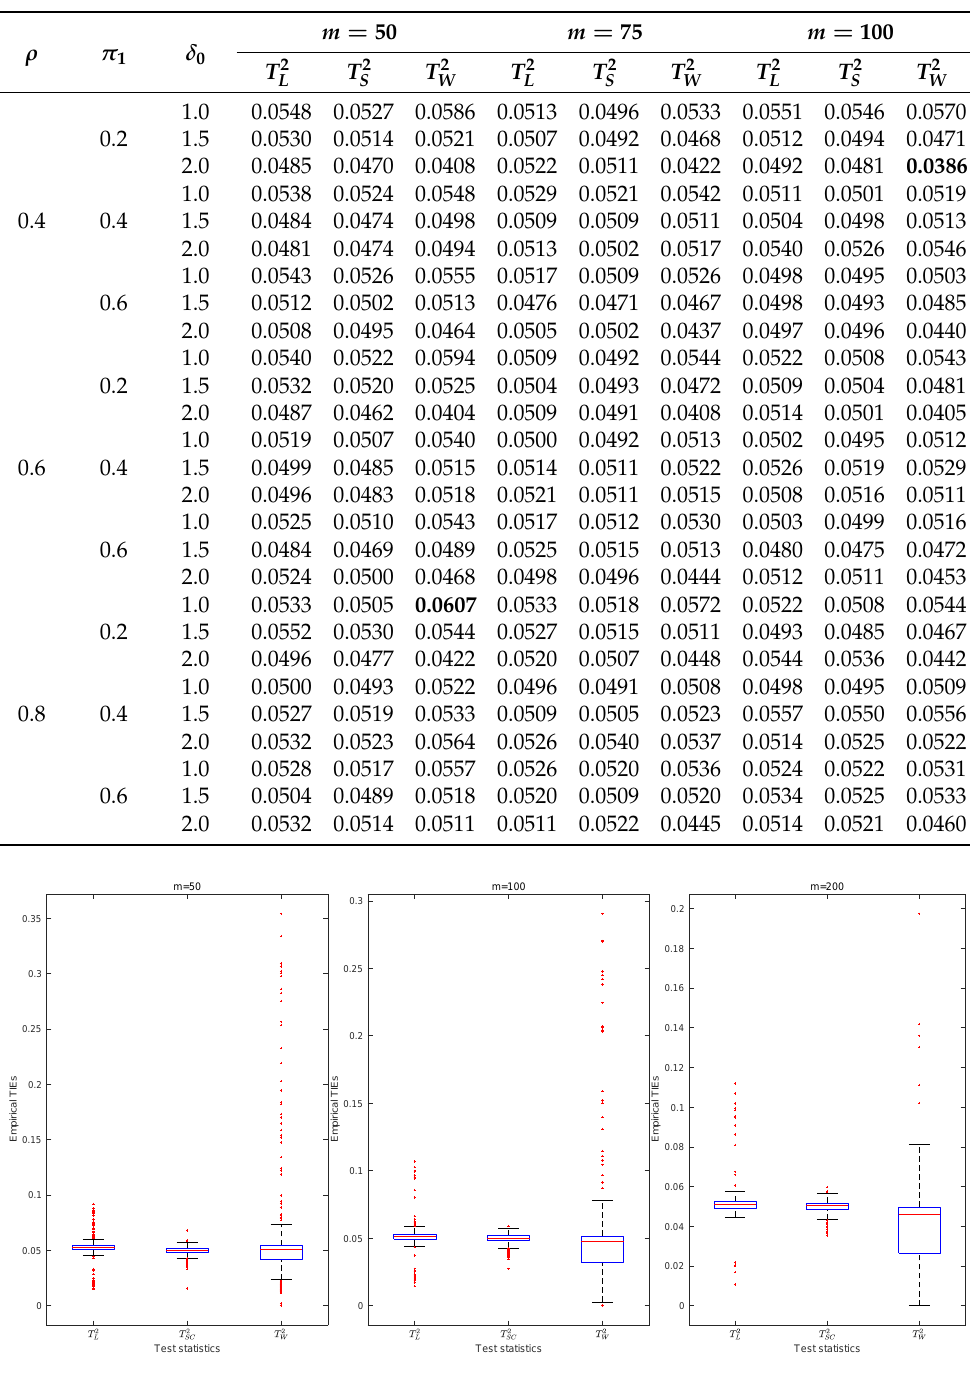
Table 2. Empirical TIEs of tests under H 0 : δ 0 = 1,1.5,2.